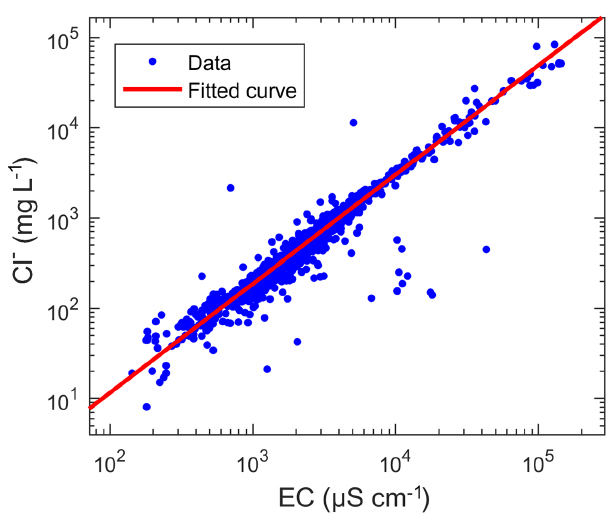
Figure 8. Cl − versus EC data in the AP catchment. The fitted function used to describe the relationship is [Cl − ]=004411 × [EC] 1 . 208 , where [Cl − ] and [EC] are in units of milligrams per litre (mgL − 1 ) and microsiemens per centimetre (µScm − 1 ), respectively (coefficient of determination: R 2 = 0 .